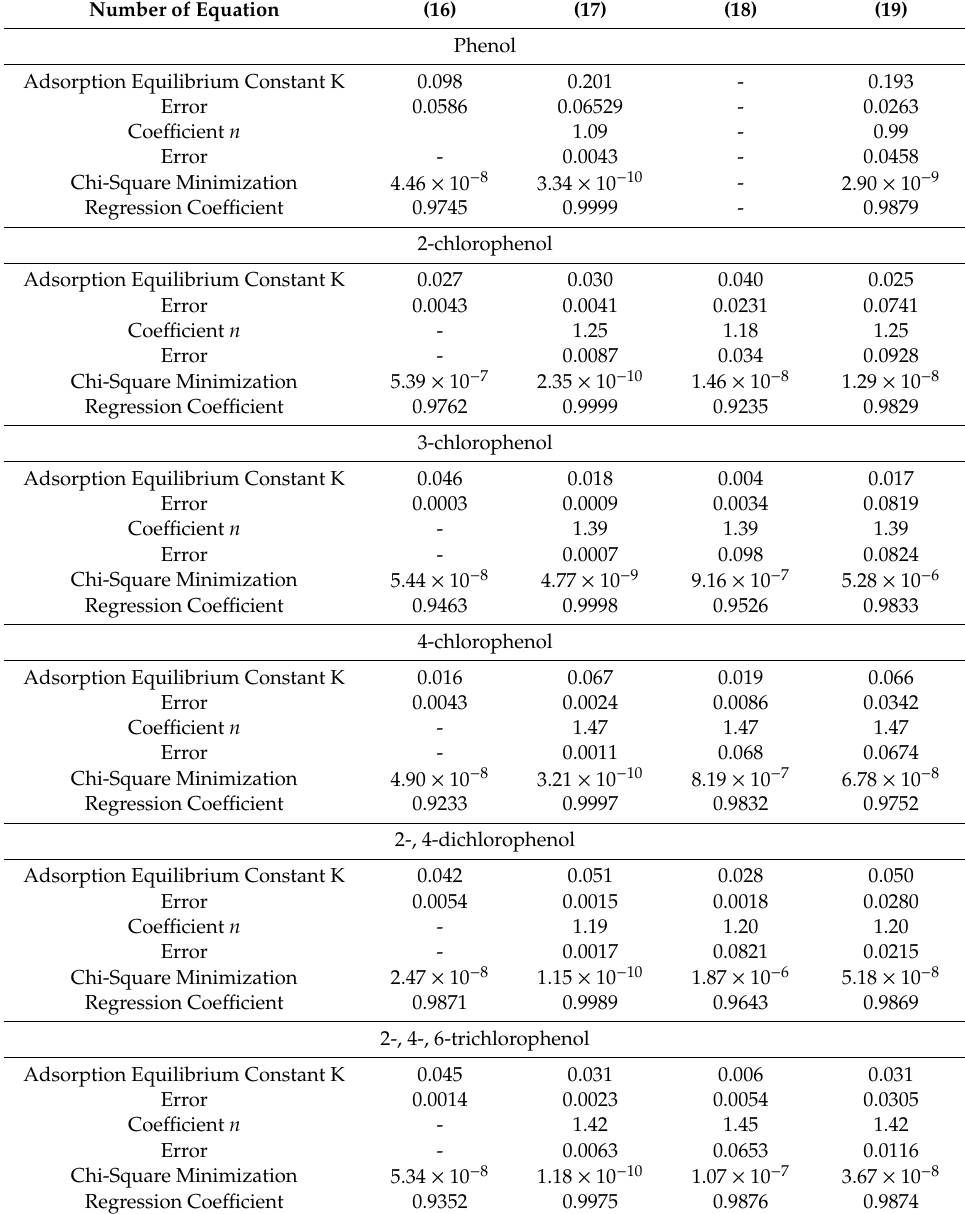
Table 5. Fit of adsorption equilibrium equation to the experimental data by the Levenberg-Marquardt least-squares method; analysis of